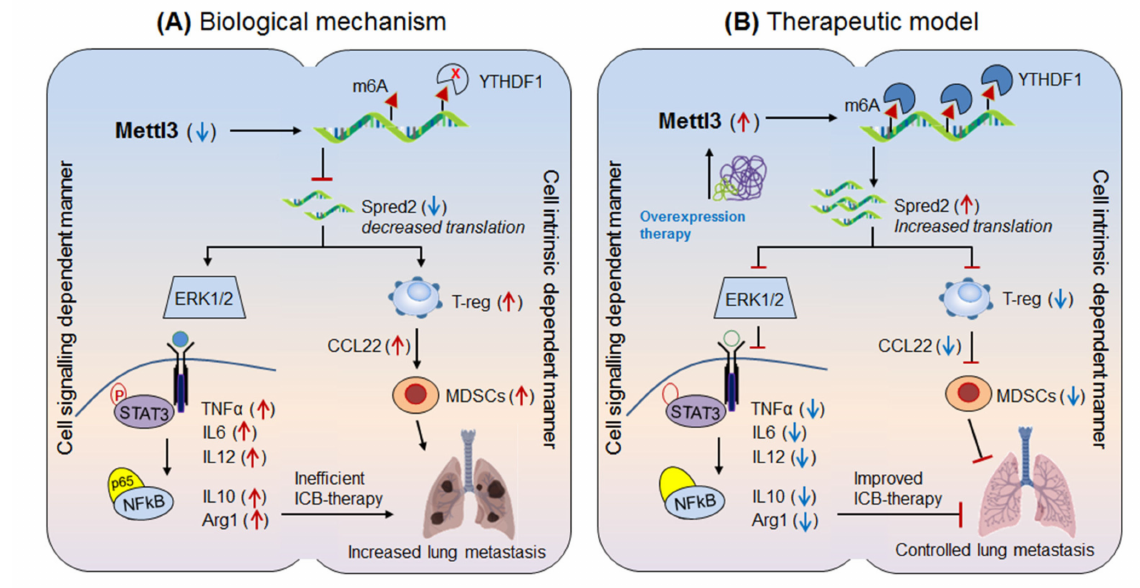
Figure 4. Therapeutic model targeting ‘Mettl-3’ in lung metastasis. ( A ) Biological mechanism: Mettl-3 is significantly down-regulated in tumor associated macrophage (TAM) and thereby alters M1/M2-macrophage-polarization and thus increases the infiltration of immunosuppressive populations (T-reg and MDSCs) in the tumor microenvironment, resulting in increased tumor growth and lung metastasis. ( B ) Therapeutic model: overexpression therapy: overexpression of Mettl-3 recruited YTHDF1-reader protein which increases the expression of its target ‘spred2’ gene, resulting in decreased infiltration of immunosuppressive cells by reducing ERK1/2 signaling, that finely reduces lung metastasis by improving the efficacy of anti-PD-1